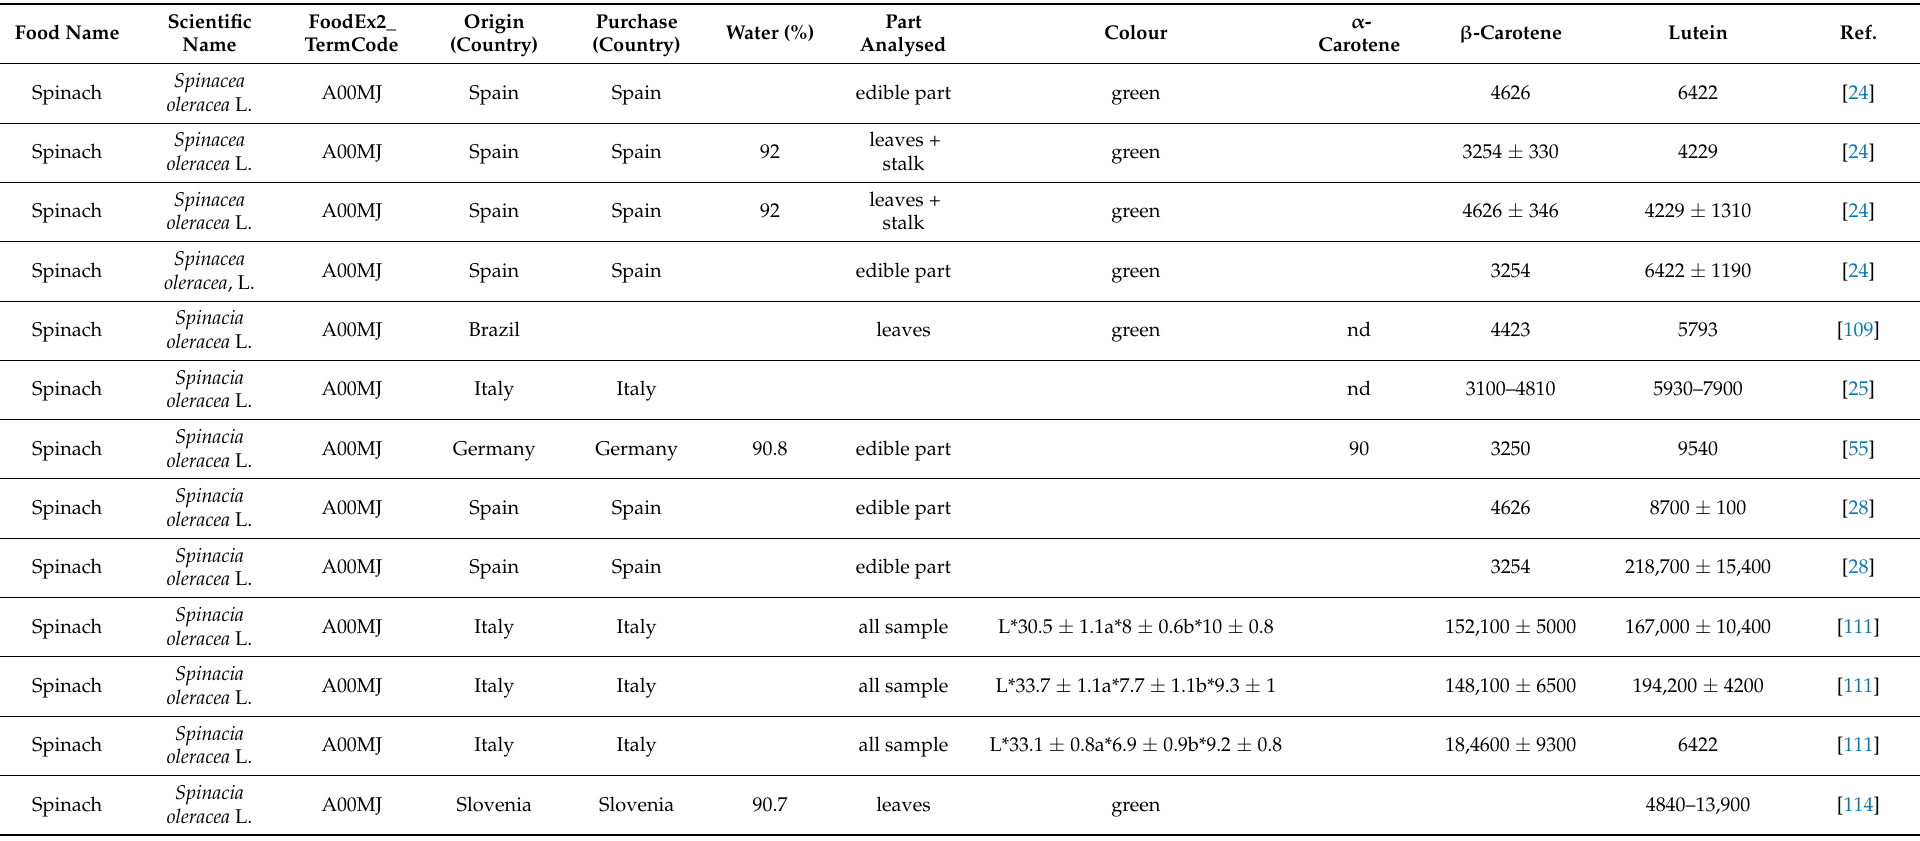
Table A2. Spinaches and similar (A00MH) ( µ g/100